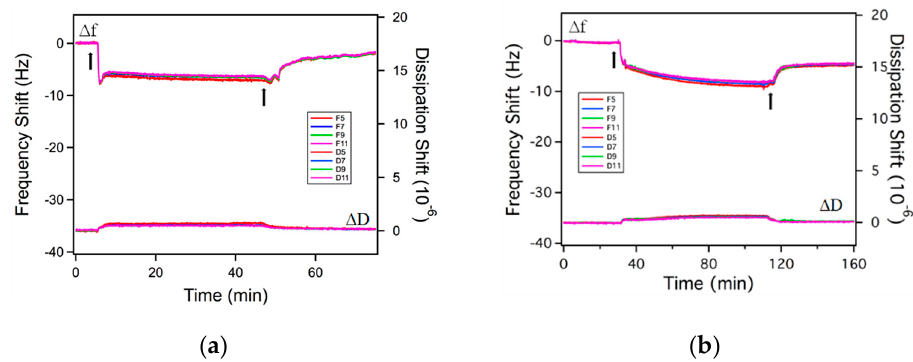
Figure 5. Δ f and Δ D over time of a gold sensor surface responding to exposure to ( a ) 0.15 wt.% R95D90 aqueous solution and ( b ) 0.15 wt.% R95D90 in 3.5 wt.% NaCl aqueous solution. The first arrow indicates the time when the rhamnolipid solution was injected and the second arrow indicates the time when solvent rinsing was initiated. Fi and Di shown in the insert are the frequency and dissipation at i th overtone, respectively.